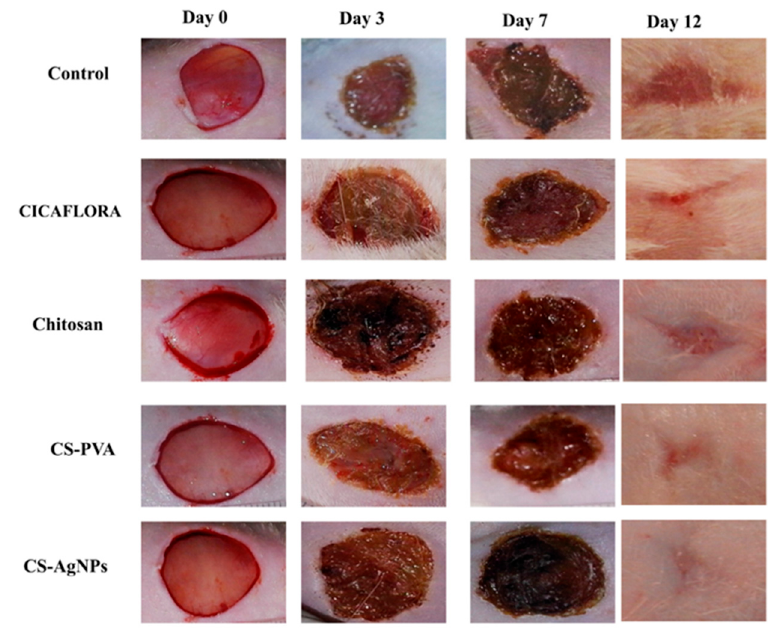
Figure 3. Representative photographs of the macroscopic appearance of wounds healing for groups treated with physiological serum (control), CICAFLORA ® , chitosan (CS), CS–polyvinyl alcohol (PVA), and CS–silver nanoparticle (AgNP) gels [124].